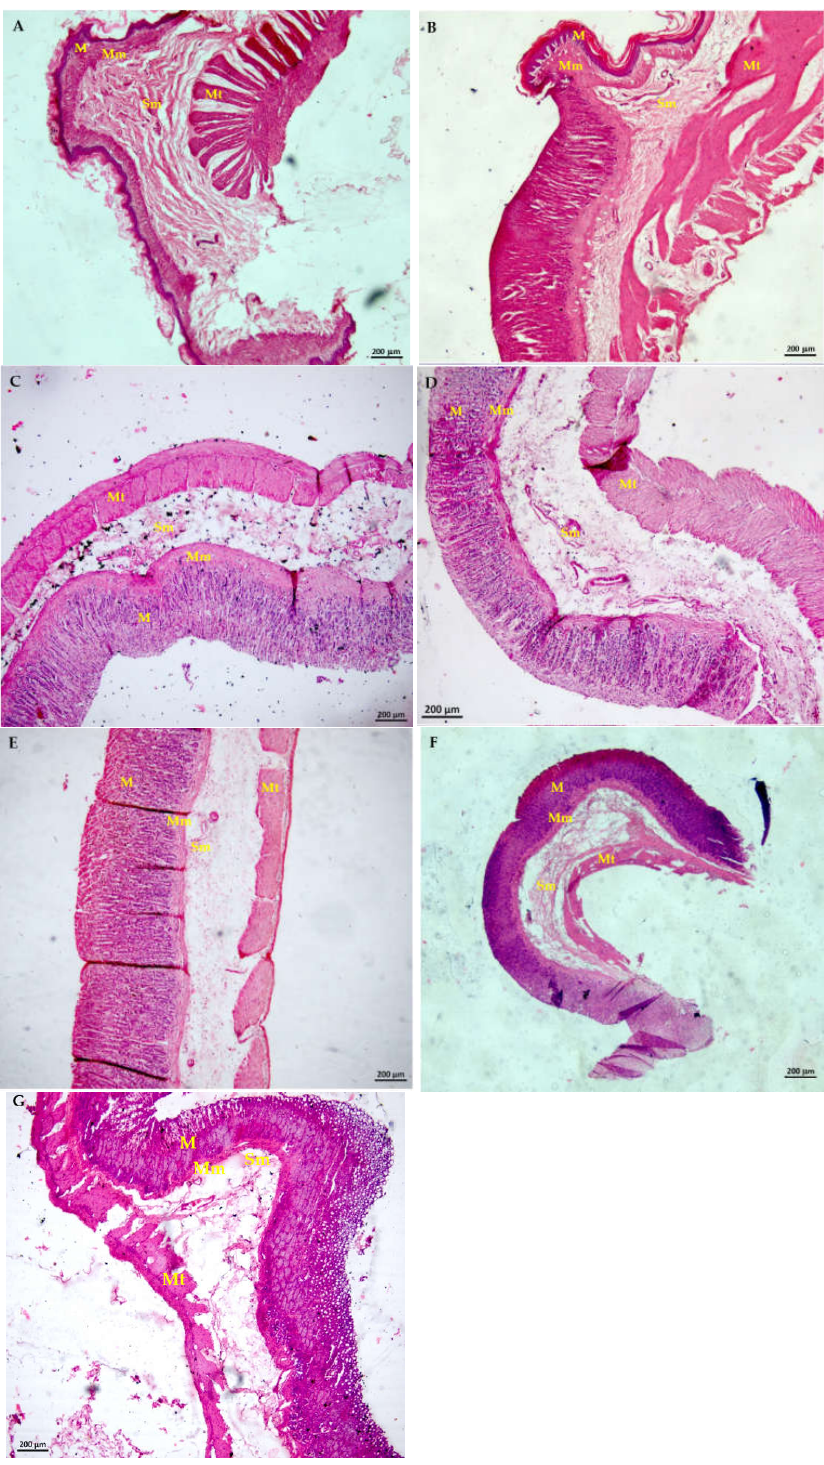
Figure 5. Effect of MaSS on the microscopic structure of the rat stomach with ethanol-induced gastric lesions. Photographs of histological sections observed at 5 × objective in a confocal scanning microscope, with an operational mode of bright field ( A ): Healthy group; ( B ): Veh group with gastric ulcers with tween 20; ( C ): L-Arg = L-arginine; ( D – G ): MaSS to 30, 90, 120 and 180 mg/kg of a mixture of kaempferol 3- O -sophoroside and kaempferol 3- O -sambubioside. M = muscularis; Mm = muscularis mucosae; Sm = submucose; Mt = muscularis